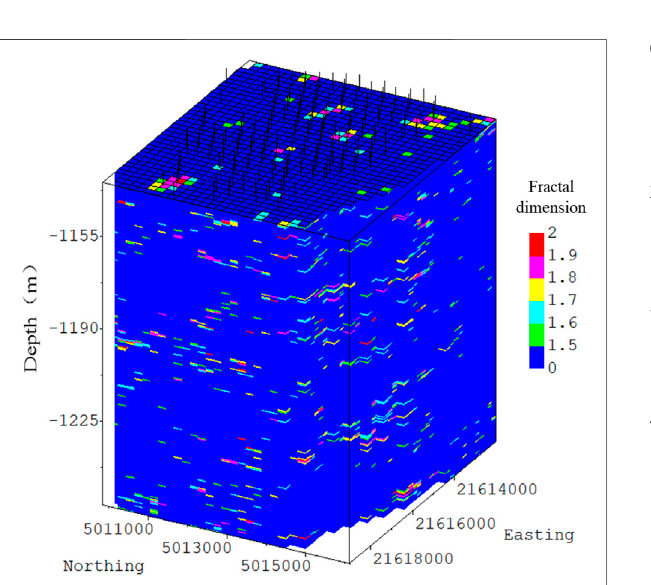
FIGURE 7 | Predicting map of fracture distribution in Xinli oil fi eld. (A) Better continuity. (B) Poor continuity.